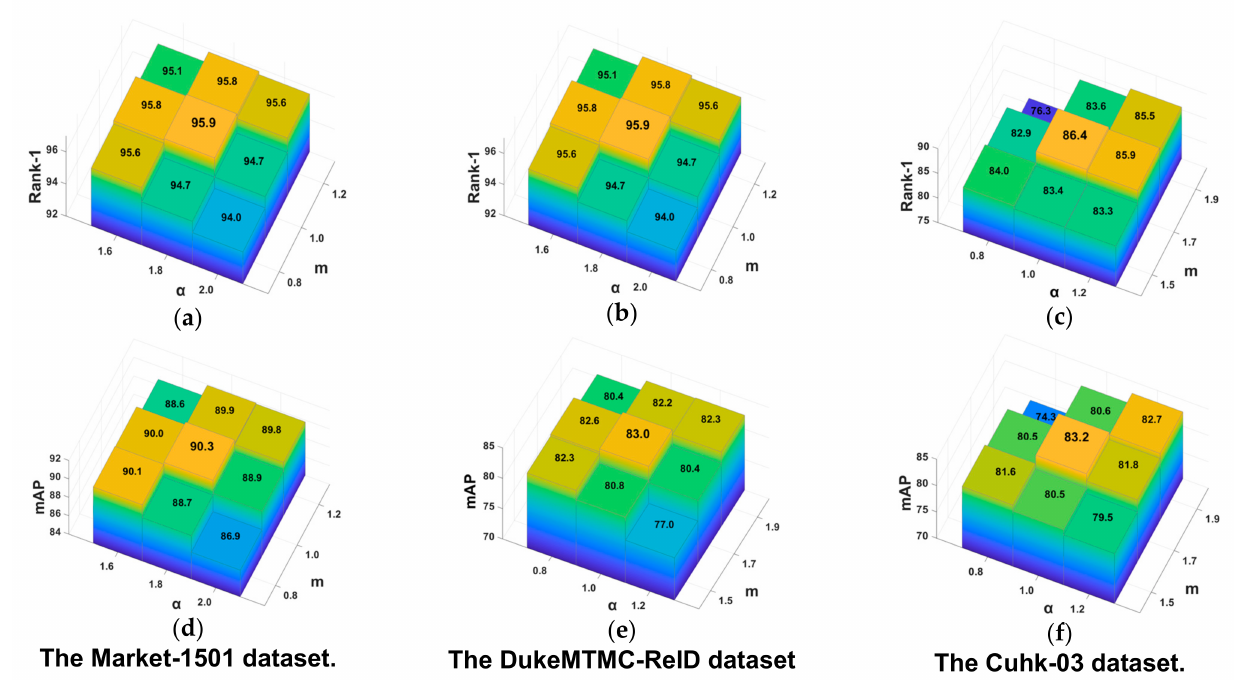
Figure 7. Hyper-parameter optimization for DBA-Net on three datasets. ( a ) The Market-1501 dataset. ( b ) The DukeMTMC- ReID dataset. ( c ) The Cuhk-03 dataset. ( d ) The Market-1501 dataset. ( e ) The DukeMTMC-ReID dataset. ( f ) The Cuhk-03